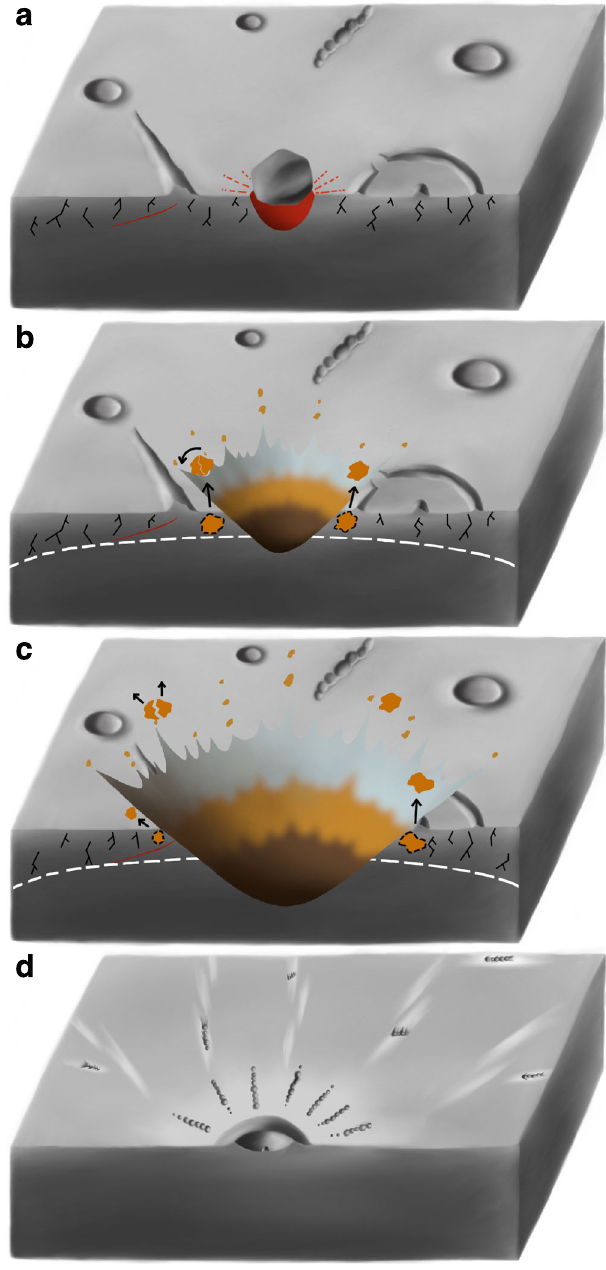
Fig.7|Illustrationforthepossiblecauseofsteepejectionanglesduringimpact spallationthatformedtheHokusaicrater.a Initialcontactbetweenanirregular- shaped projectile and the northern volcanic plains on Mercury. Subsurface frac- tures and various forms of topographic undulations existed in the pre-impact tar- get, such as buried impact craters, wrinkle ridges, and earlier-formed secondaries. b , c Impact spallation in the near-surface target materials. Spall fragments exca- vated from the vicinity of topography undulations may exhibit abrupt changes of ejection angles. Rotational segmentation may occur in some fast-spinning spall fragments (black curved arrow in b ). d Impact rays and their interior secondaries. Distal ejecta with abnormal ejection angles would form non-radial distributions of secondaries in distal rays. The azimuth of landing of impact ejecta can be derived based on the morphology of